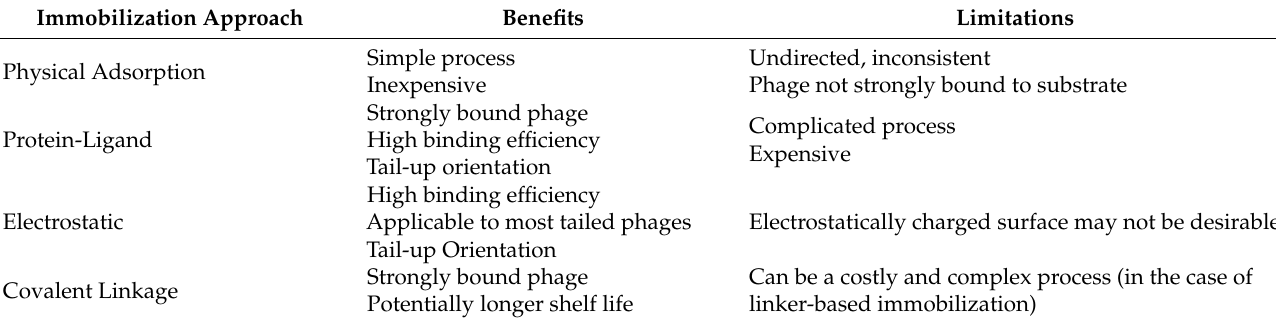
Table 4. Summary of benefits and limitations associated with various bacteriophage immobilization techniques for the production of therapeutic phage